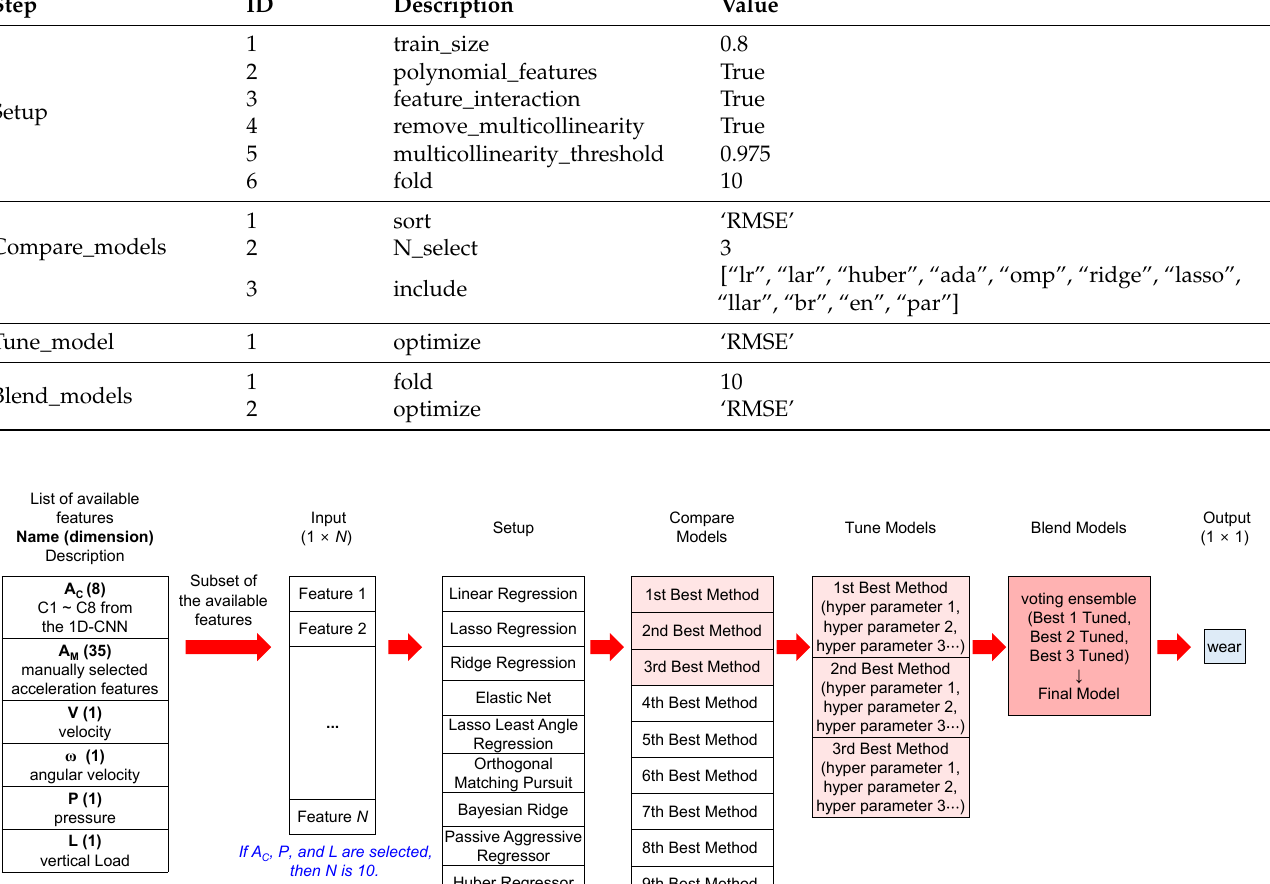
Table 3. List of altered parameters from the default values for AutoML method (PyCaret 2.3.10).